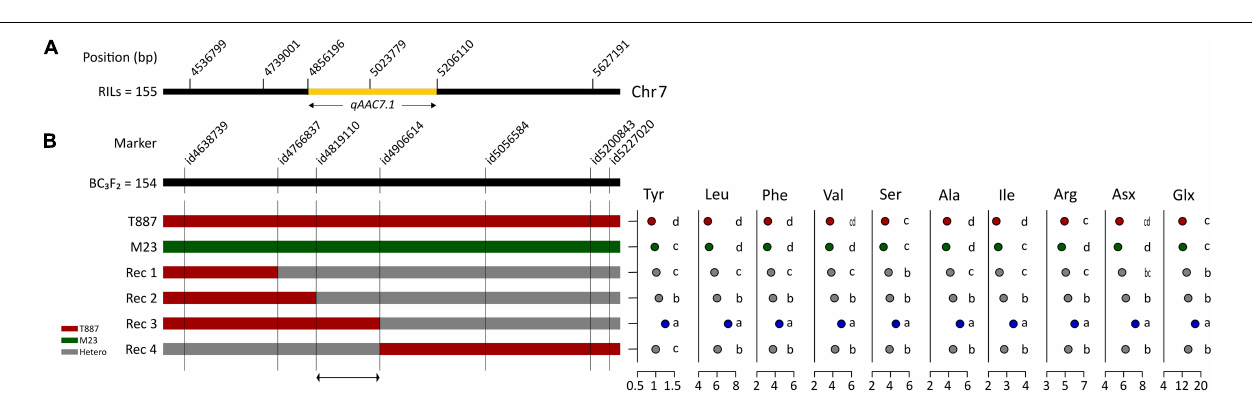
FIGURE 3 | Allelic effects for AACs in 155 RILs. Allelic effects of qAAC6.1 (A) and qAAC7.1 (B) . Asterisk represents statistically significant difference (** p ≤ 0.01). Red box and green box represent the average AAC of each line containing the alleles originated from T887 and M23, respectively. (C) Effect of different allelic combination of qAAC6.1 and qAAC7.1 . Different letters indicate significant differences between groups ( p ≤ 0.05, Tukey’s HSD test). N, the number of lines.